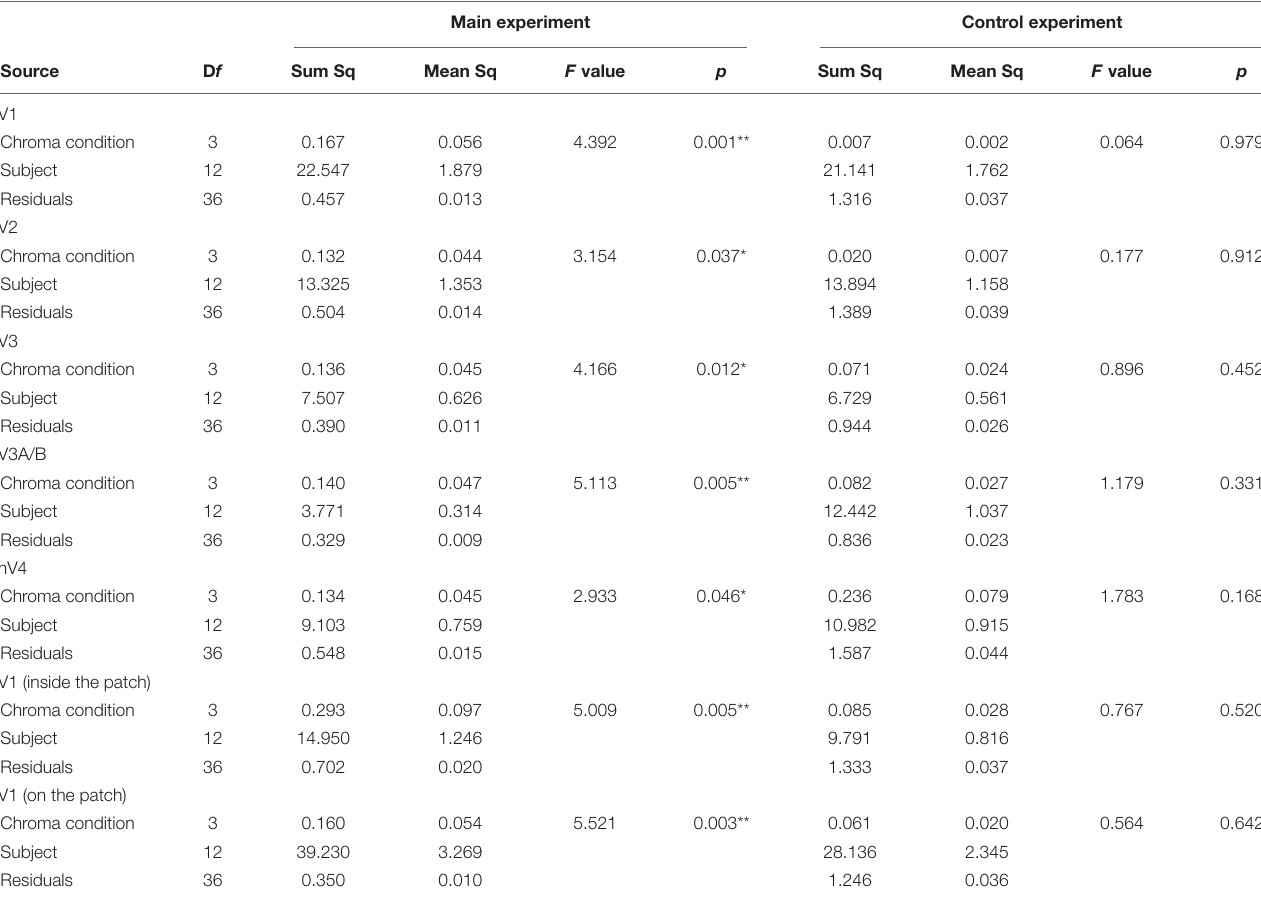
TABLE 1 | ANOVA results of fMRI experiments for each visual